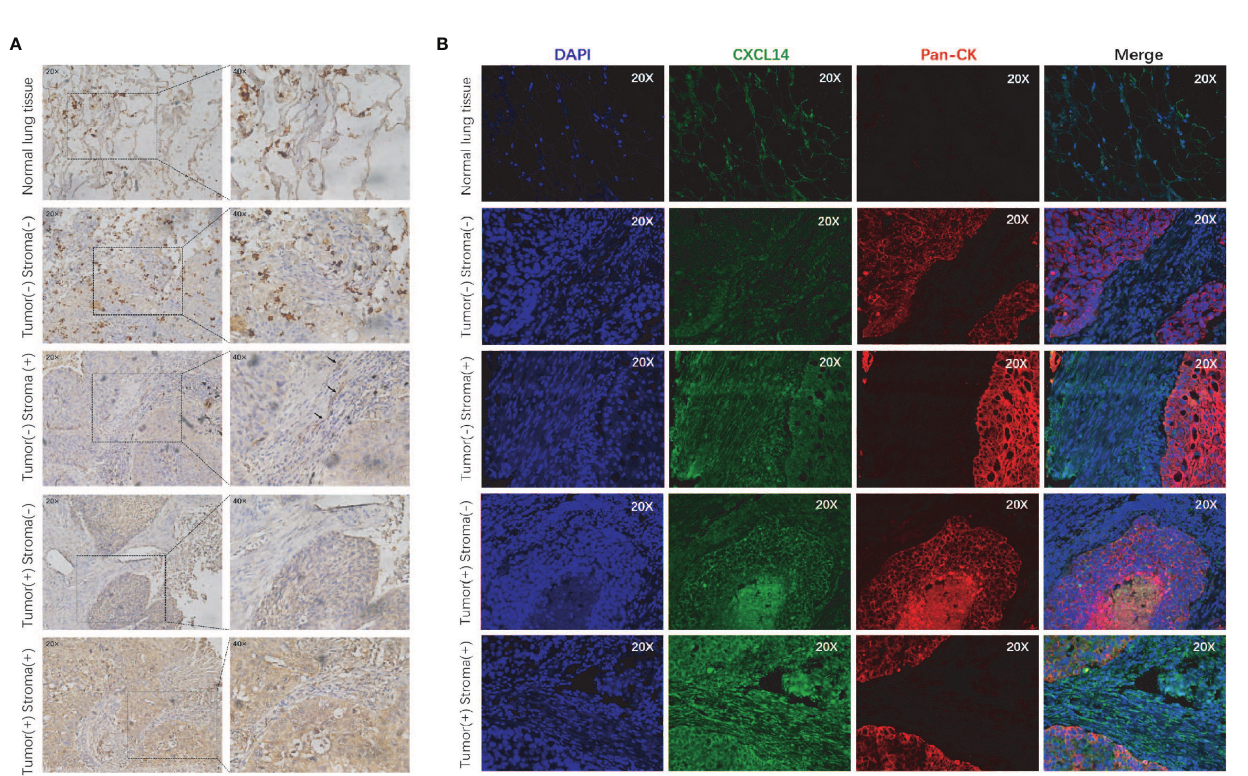
FIGURE 4 | CXCL14 expression in lung cancer tissues. (A) Representative images of immunohistochemical staining of CXCL14 in normal lung tissue and lung cancer tissues; magni fi cation, ×20 (left) and ×40 (right). (B) Representative images of immuno fl uorescence staining of CXCL14 in normal lung tissue and lung cancer tissues. The left column shows the cell nuclei in blue (DAPI); the next column shows the presence of CXCL14 in green; the third column shows the cancer cells in red (pancytokeratin), and the fi nal column shows a merged image of the three